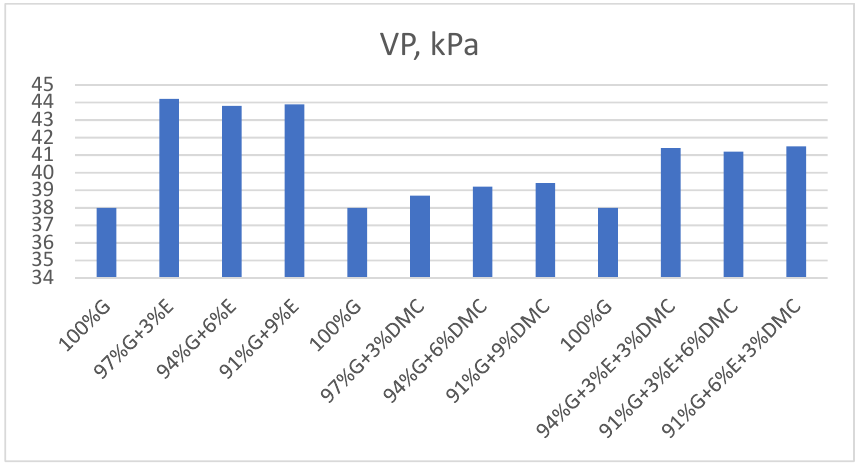
Figure 2. RVP of binary G+E and G+DMC blends and ternary G+E+DMC blends (components’ proportions expressed in % v / v ).